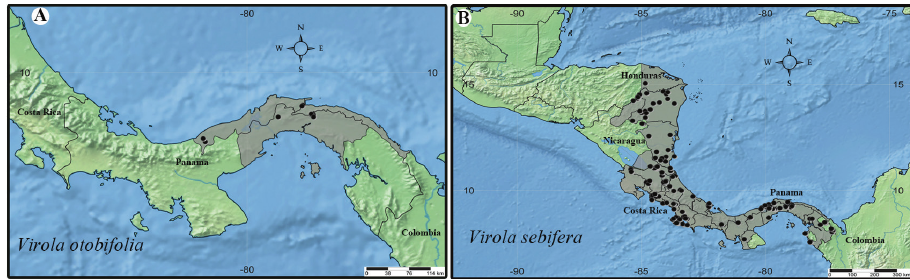
Figure 27. Geographic distribution of Virola otobifolia ( A ) and V. sebifera ( B ).